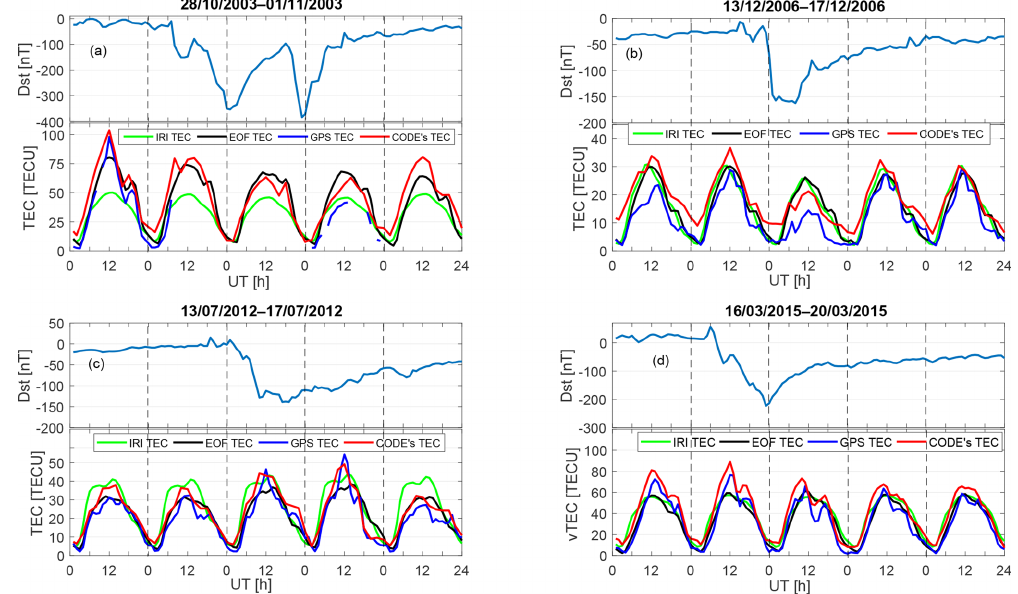
Figure 4. GPS TEC, IRI TEC, CODE’s TEC and EOF TEC over Malindi for some selected storms. In these plots, the GPS TEC values are taken as a true representation of the ionosphere over Malindi. However, in the absence of GPS TEC (as in the case of the storm of 29–31 October 2003 shown in a ), CODE’s TEC was taken as the correct description of the ionospheric response to the